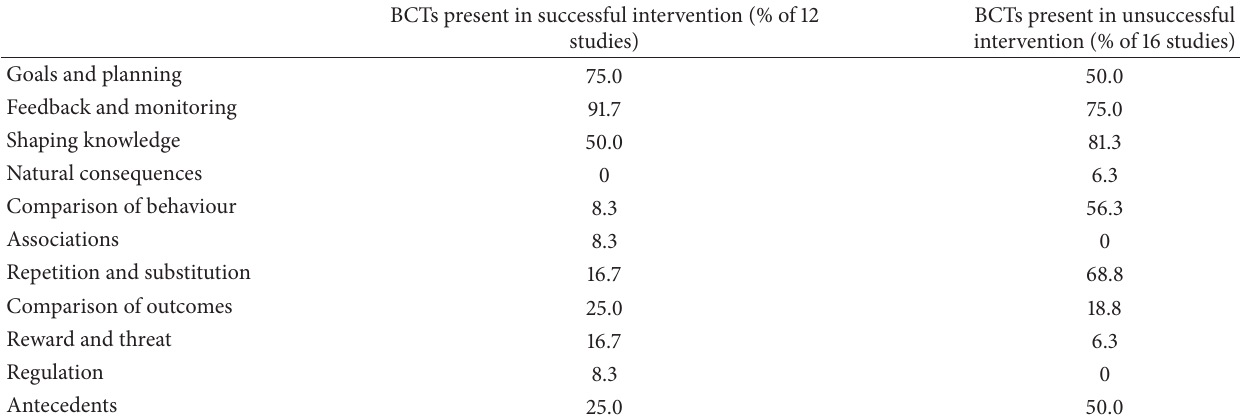
Table 3: Prevalence of BCT categories within successful and unsuccessful interventions at reducing gestational weight gain. BCTs present in successful intervention (% of 12